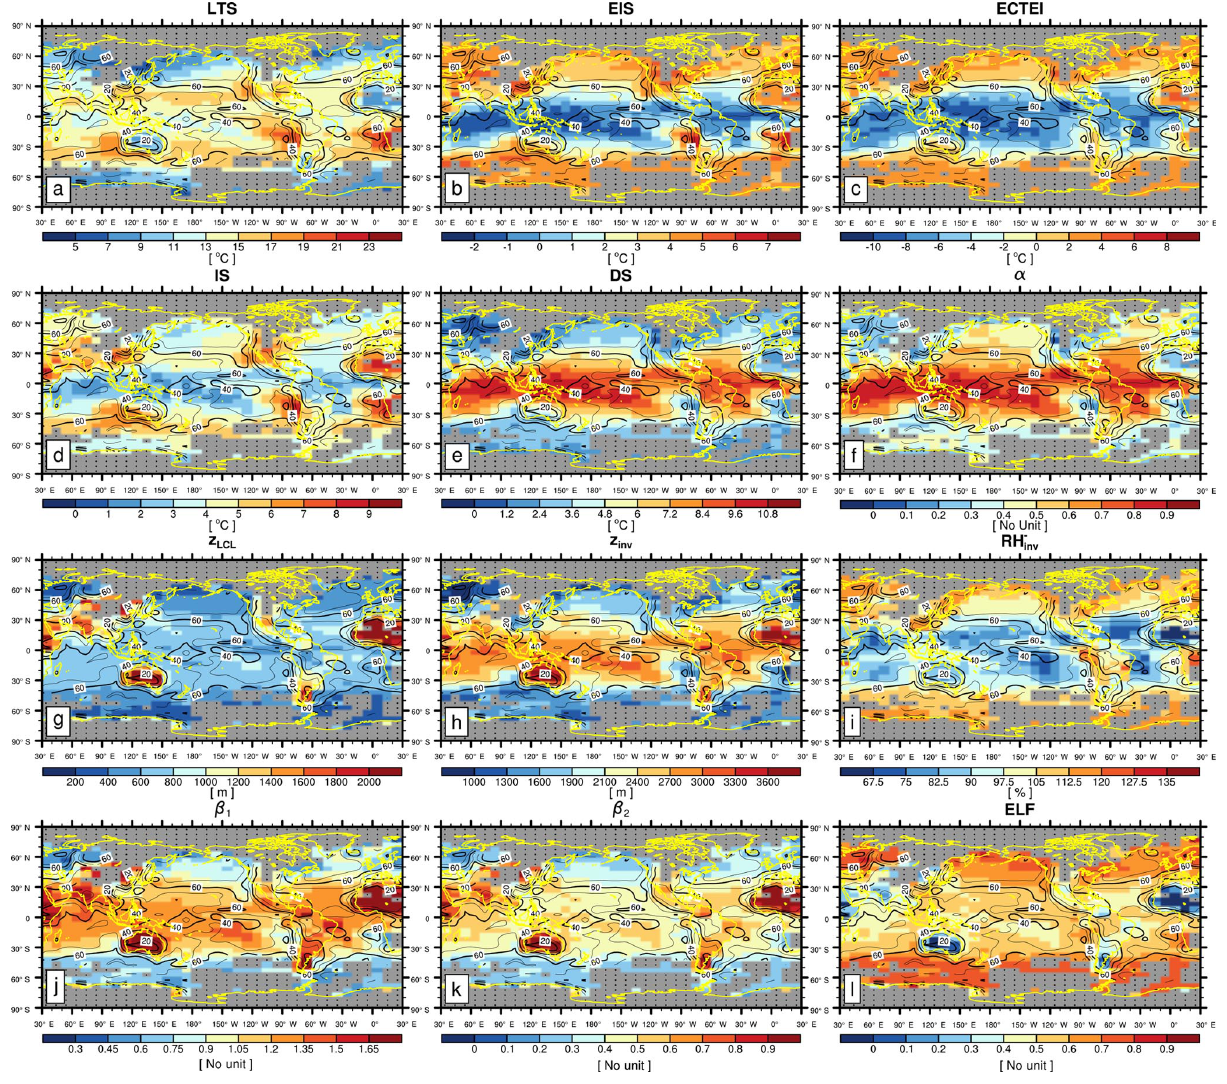
Figure 4. The same as Fig. 3 but in December–January–February